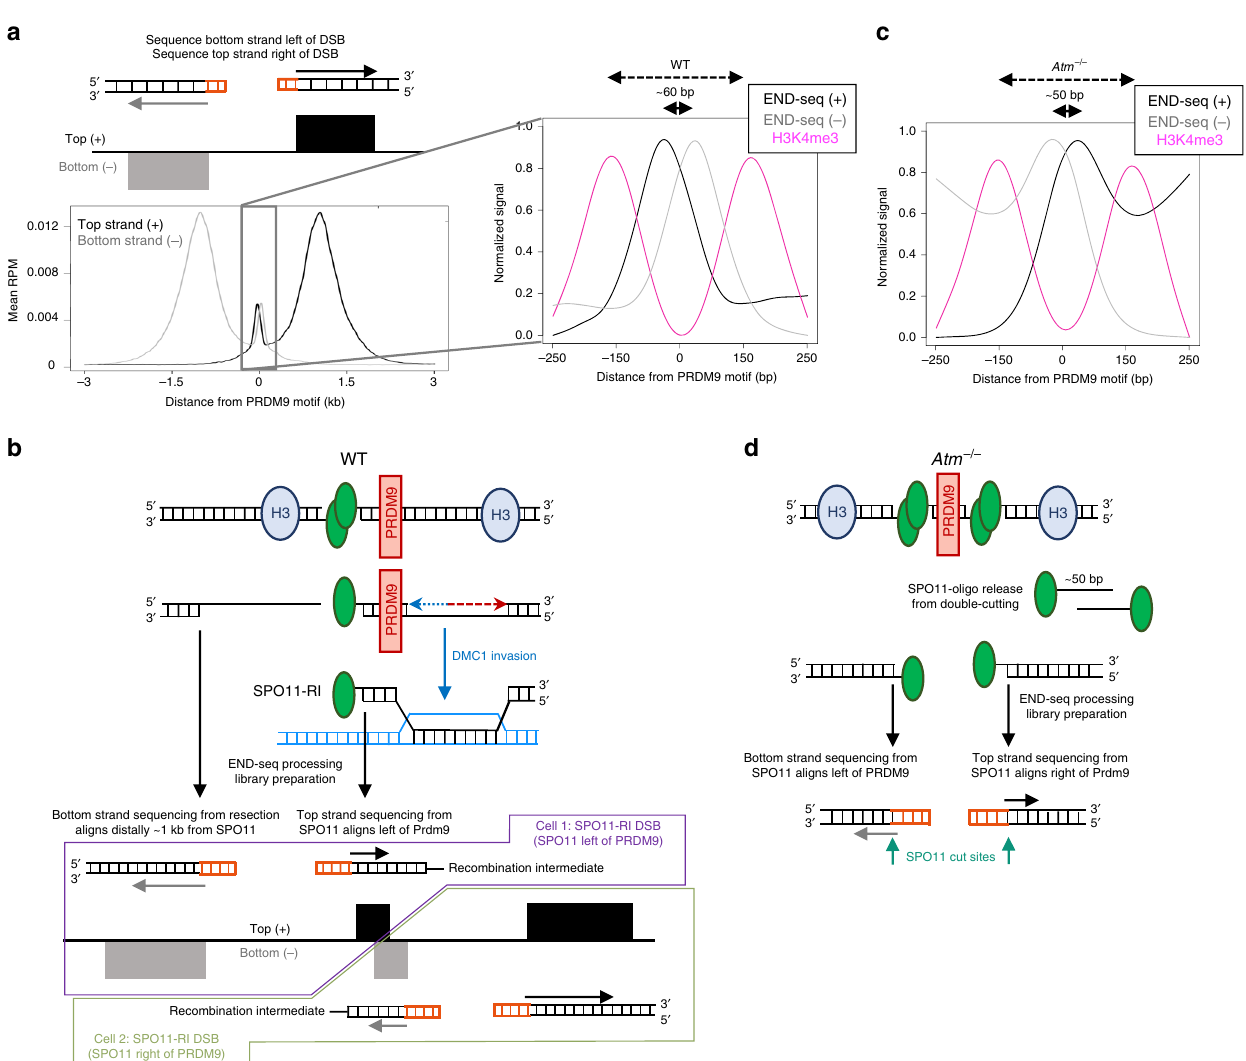
Fig. 8 Polarity of END-seq reads re fl ects distinct natures of SPO11 cutting and processing in WT and ATM-null cells. a At fully processed and resected SPO11 DSBs, END-seq top and bottom strand reads exhibit a “ correct ” polarity to the right and left of the DSB, respectively (left). WT reads at the center of hotspots show a strand polarity that is reversed from what is expected (right, zoomed in at NDR). b PRDM9 as a barrier to SPO11 processing that results in a SPO11-bound recombination intermediate (SPO11-RI) structure. In WT, SPO11 cutting to one side of chromatin-bound PRDM9 within the NDR may block MRE11 activity on one side of the break, leaving SPO11 covalently bound to a short stretch of dsDNA, capping the DMC1-loaded ssDNA that extends ~ 1 kb from the NDR. SPO11-RI is sequenced starting from the fi rst SPO11-bound nucleotide where an adapter is ligated. SPO11 that cut left of PRDM9 would result in top strand reads aligning to the left of the PRDM9 motif and bottom strand reads from fully resected ssDNA aligning at a distance away from the break site. c Atm – / – END-seq central reads have correct separated strand polarity within the NDR. d Unresected SPO11 double-cutting within the same hotspot in Atm – / – cells would show the correct polarity of top and bottom strands after adapter ligation to SPO11-bound DSBs and ~ 50 bp separation, as observed in c . Decreased MRE11 activity at these breaks would result in the direct sequencing of SPO11 cleavage complexes within the NDR rather than SPO11-RI in